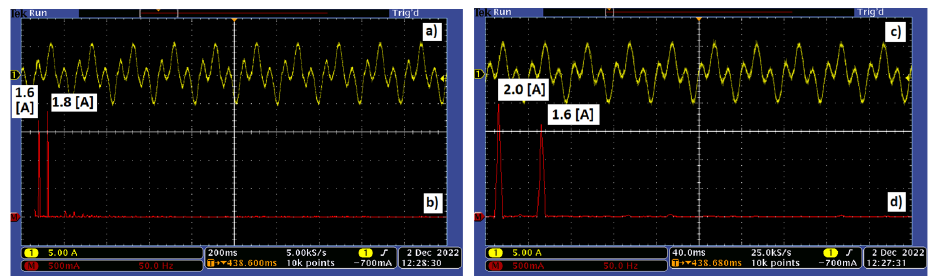
Figure 6. Current waveform for phase B (( a ) rotational speed 150 rpm, ( c ) rotational speed 750 rpm) for a motor supplied with a voltage containing the third harmonic and its spectrum (( b ) rotational speed 150 rpm, ( d ) rotational speed 750 rpm).